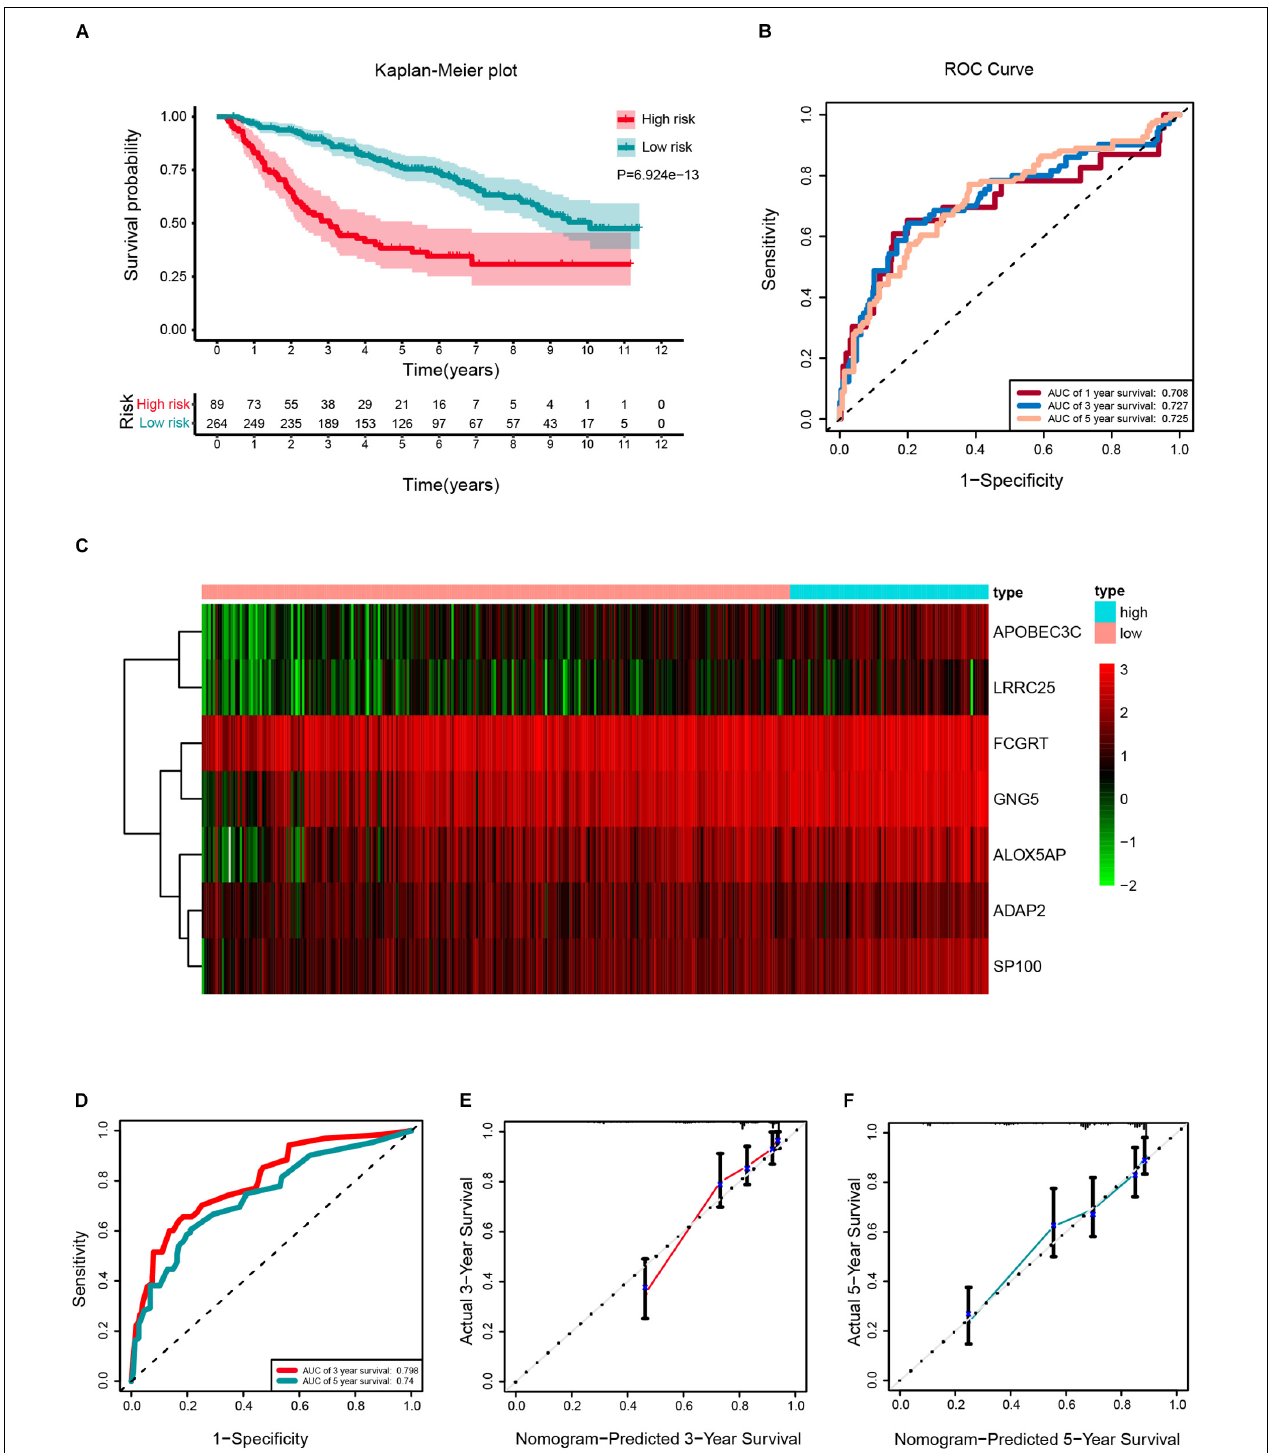
FIGURE 8 | External validation of a prognostic stemness index-related gene signature for primary low-grade glioma (LGG). (A) Kaplan-Meier analysis of OS for low-risk and high-risk patients in the external validation cohort. Additionally, the table indicating the number at risk for each group at corresponding time points. (B) The time-dependent receiver operating characteristics (ROC) curve for 1-, 3-, and 5-years OS predictions for the nomogram compared with actual observations. (C) The heatmap shows the expression of the seven genes between two risk groups in the CGGA cohort. (D) Time-dependent ROC for 3- and 5-years OS predictions for the nomogram compared with actual observations. Calibration plot of nomogram for predicting probabilities of 3- (E) and 5-year (F) OS of primary LGG patients in the CGGA database.